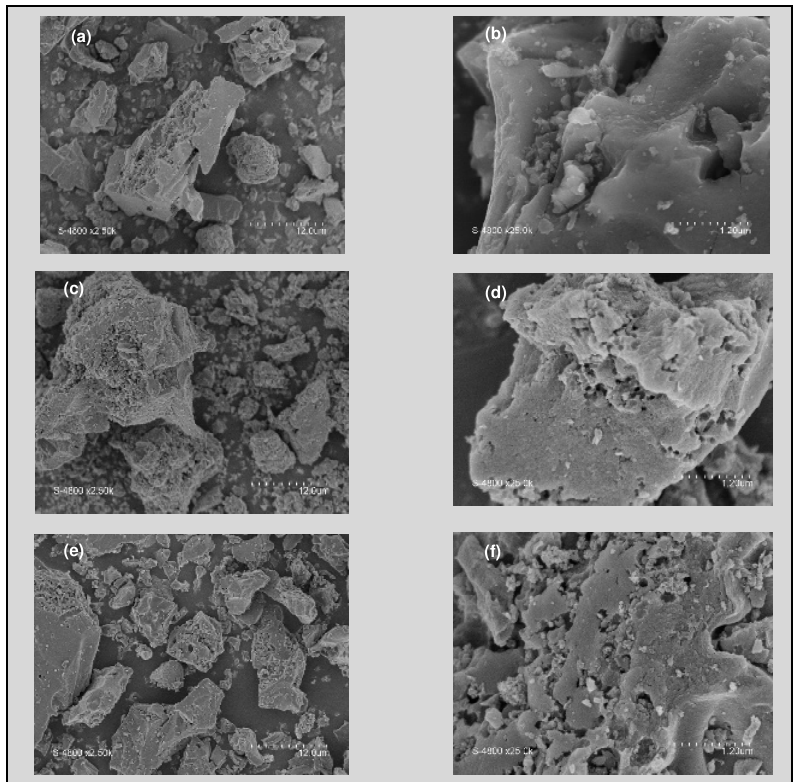
Fig. 2. SEM images of activated carbons: (a) and (b) Norit B SUPRA EUR, (c) and (d) Norit A SUPRA EUR gross, (e) and (f) Norit A SUPRA EUR sterilized